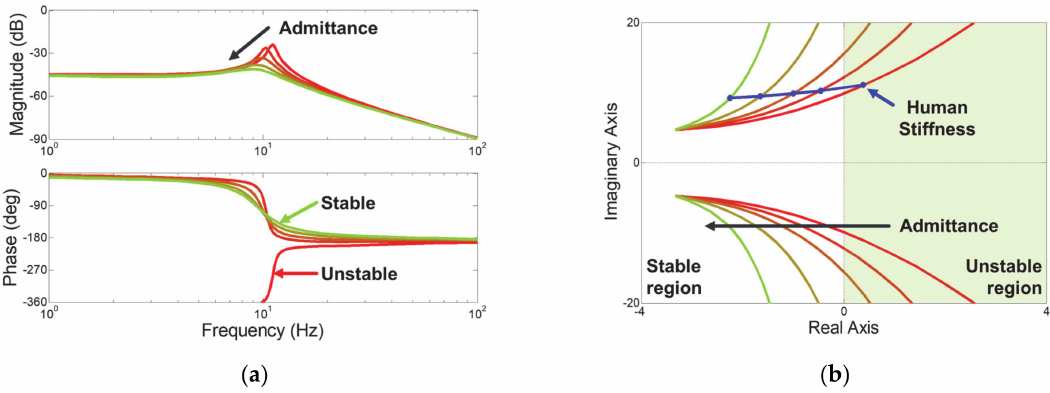
Figure 4. Stability analysis of admittance control for desired inertia m d and damper d d at a fixed ratio. ( a ) Frequency response for human stiffness of 176.39 N/m. ( b ) root locus plot for increasing external